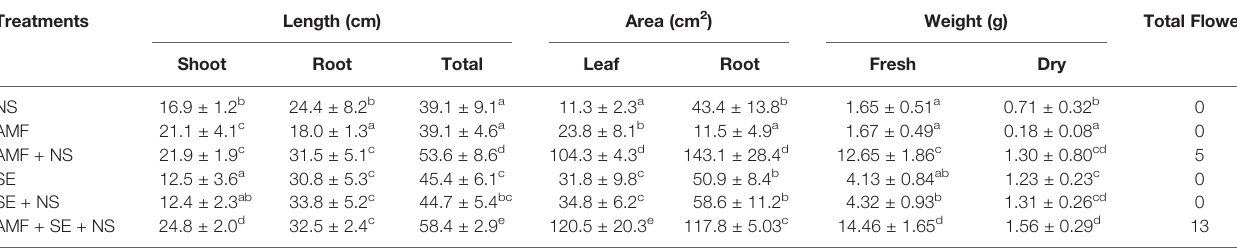
TABLE 1 | Growth of tomato plants treated with plant